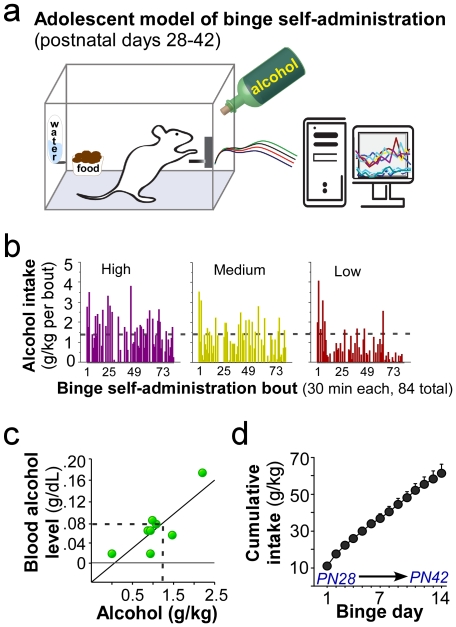
Operant model of binge alcohol self-administration in adolescent male Wistar rats.(a) Illustration of the binge self-administration apparatus. (b) The pattern of alcohol intake (g/kg) from representative high (n = 8; 76.8±3.5 g/kg total intake; 27.1±2.1 total number of binges), medium (n = 6; 63.6±3.3 g/kg total intake; 22.5±2.7 total number of binges), and low (n = 6; 35.3±2.8 g/kg total intake; 35.3±2.8 total number of binges) binging rats over the two week treatment period (14 overnight sessions×6 bouts = 84 sessions total). (c) A scatter plot showing the relationship between g/kg intake and resultant blood alcohol levels in a single bout on the last binge day in a subset of rats. A linear fit trend line is used to estimate the average g/kg intake that results in ≥0.08 g% blood alcohol levels (i.e., ∼1.25 g/kg would be classified as “binge drinking”). As shown in (b) and (c) not all animals binge within a single session and instead vary regarding the bout(s) in which they binge within each overnight session and the total number of binges over the two-week treatment period. (d) By the time animals reach postnatal day (PN) 42 the cumulative intake approaches 50–60 g/kg. Data are expressed as mean ± SEM (c: n = 8 binge rats; d: n = 20 binge rats).